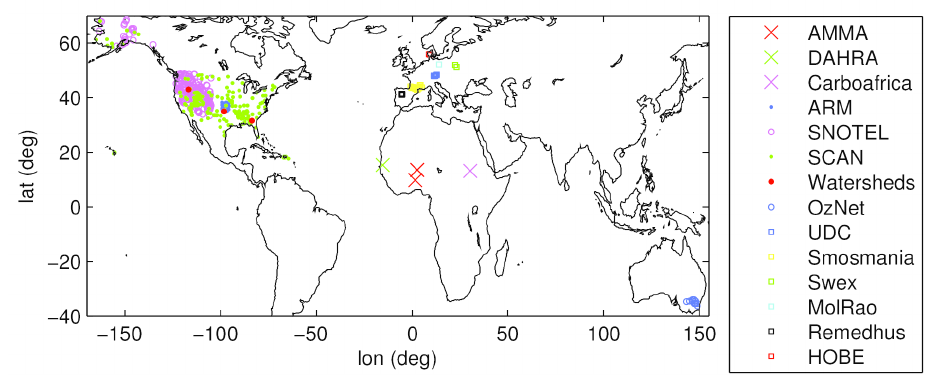
Figure 1. Locations of the in situ